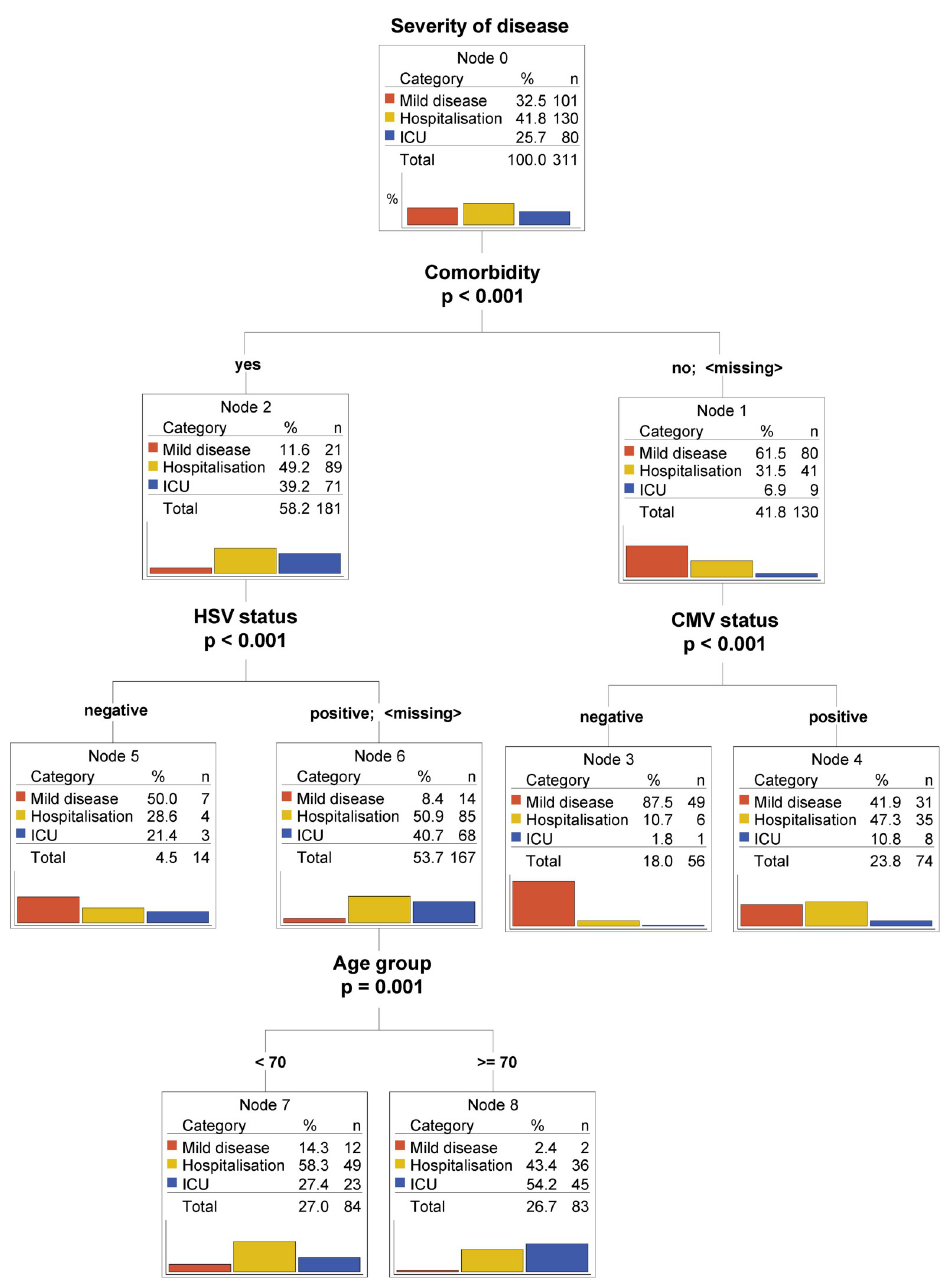
Fig 3. CMV serostatus remains an independent predictor of worse outcome for young patients with no comorbidities. Classification tree model (CHAID) using CMV serostatus, HSV serostatus, comorbidities and age as predictors. Bar plots represent percentages. Percentages for categories (mild disease, hospitalization and ICU) are calculated within the node. Percentages for the totals are calculated using the entire dataset.